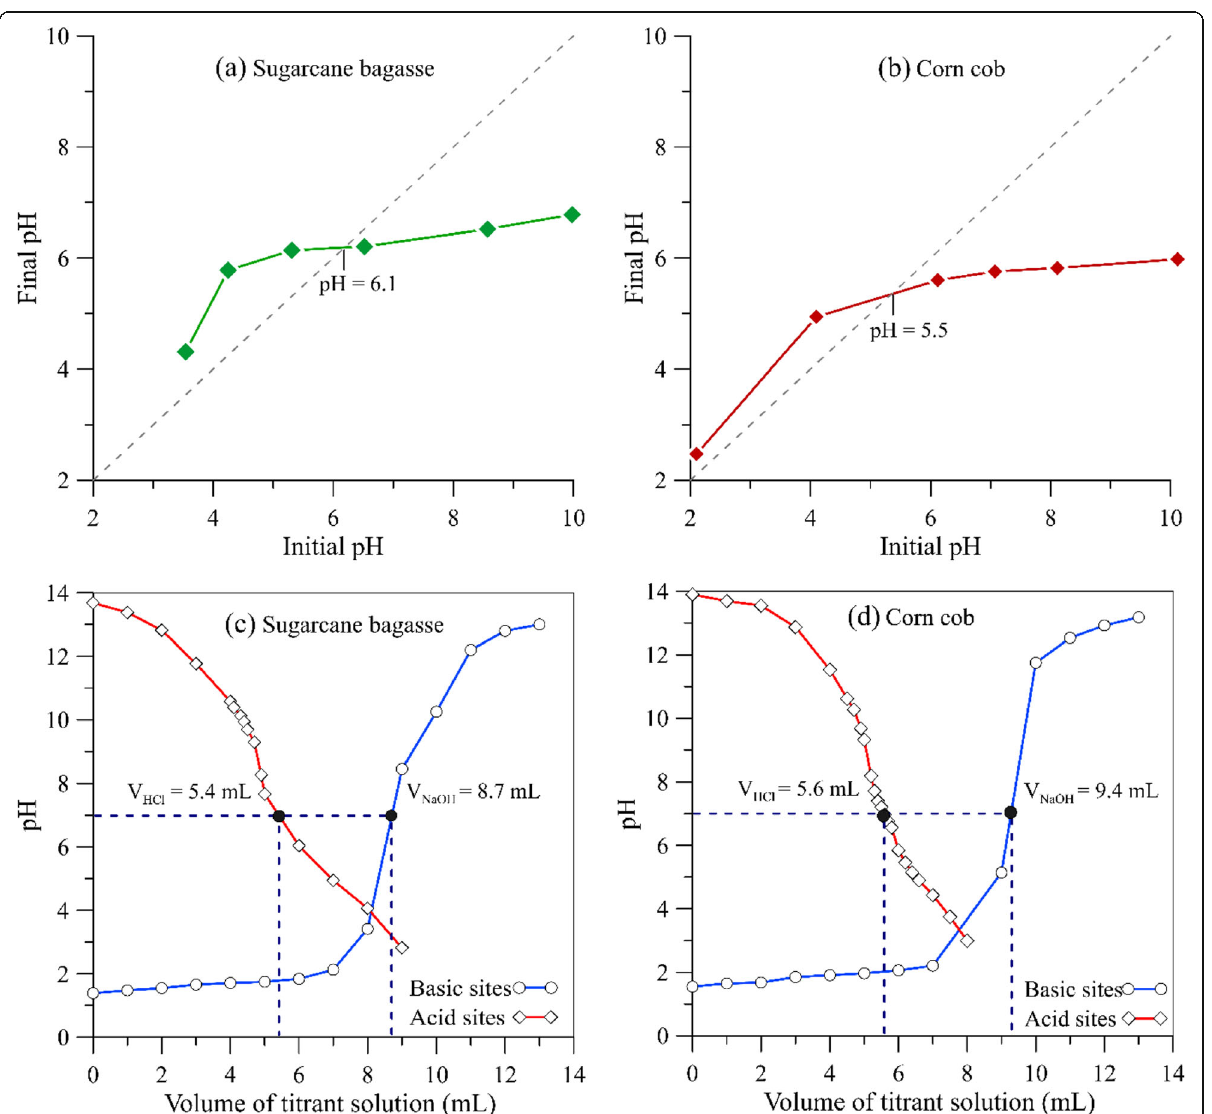
Fig. 1 pH PZC of SB ( a ) and CC ( b ), and titration curves for the acidic and basic sites of SB ( c ) and CC ( d